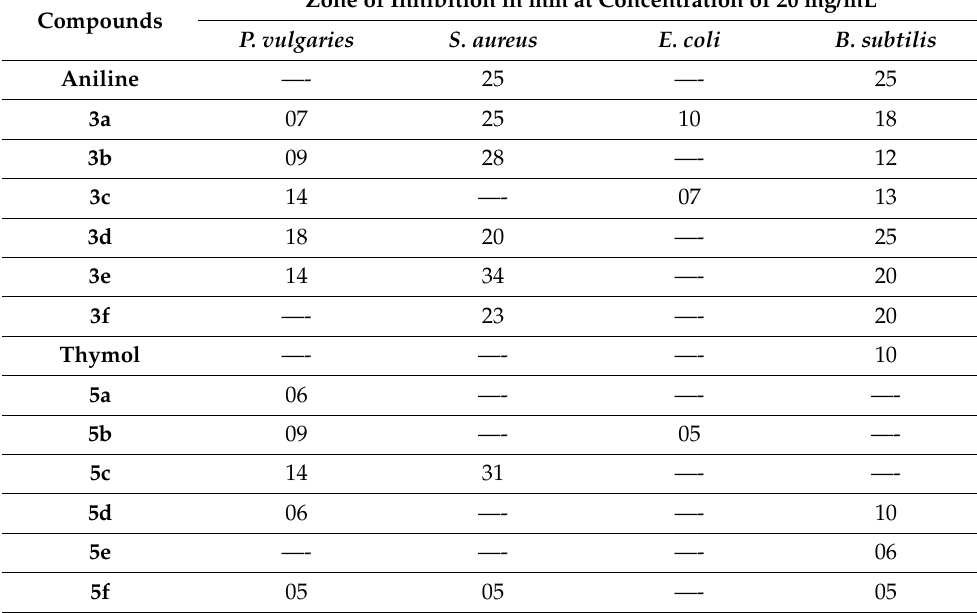
Table 3. Antibacterial activities of compounds 3a–f and 5a–f . Zone of Inhibition in mm at Concentration of 20 Compounds